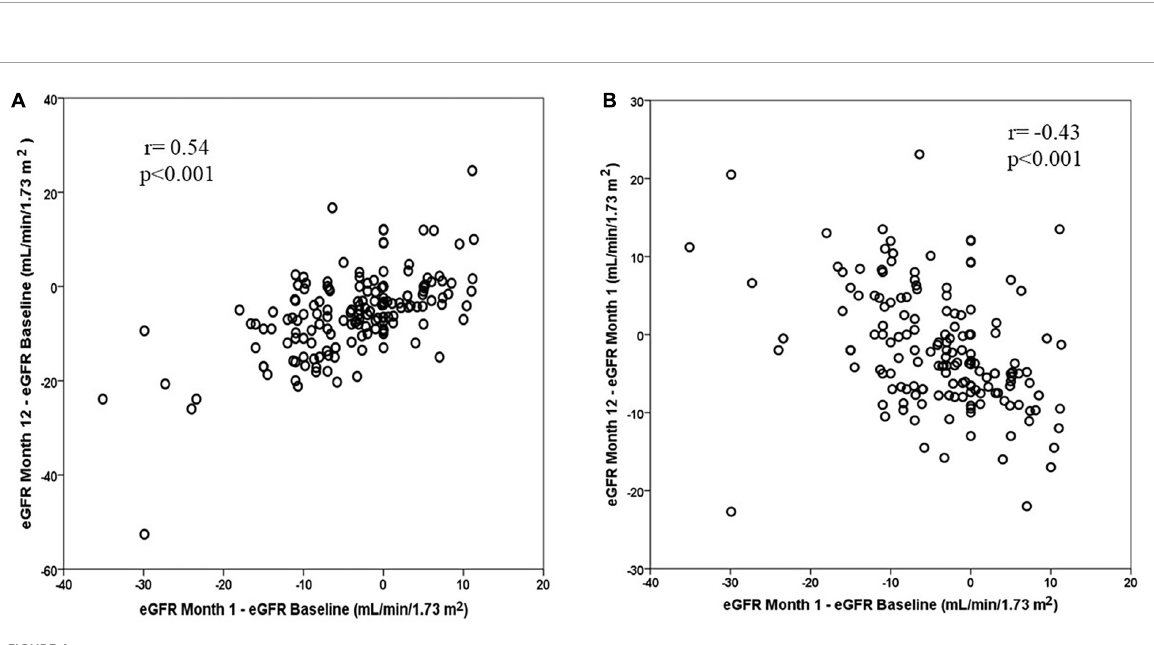
FIGURE4 (A) Correlation between the change in eGFR in the first year from its baseline value and the change in eGFR in the first month from its baseline value. (B) Correlation between change in eGFR in the first year from the first month and the change in eGFR in the first month from the baseline